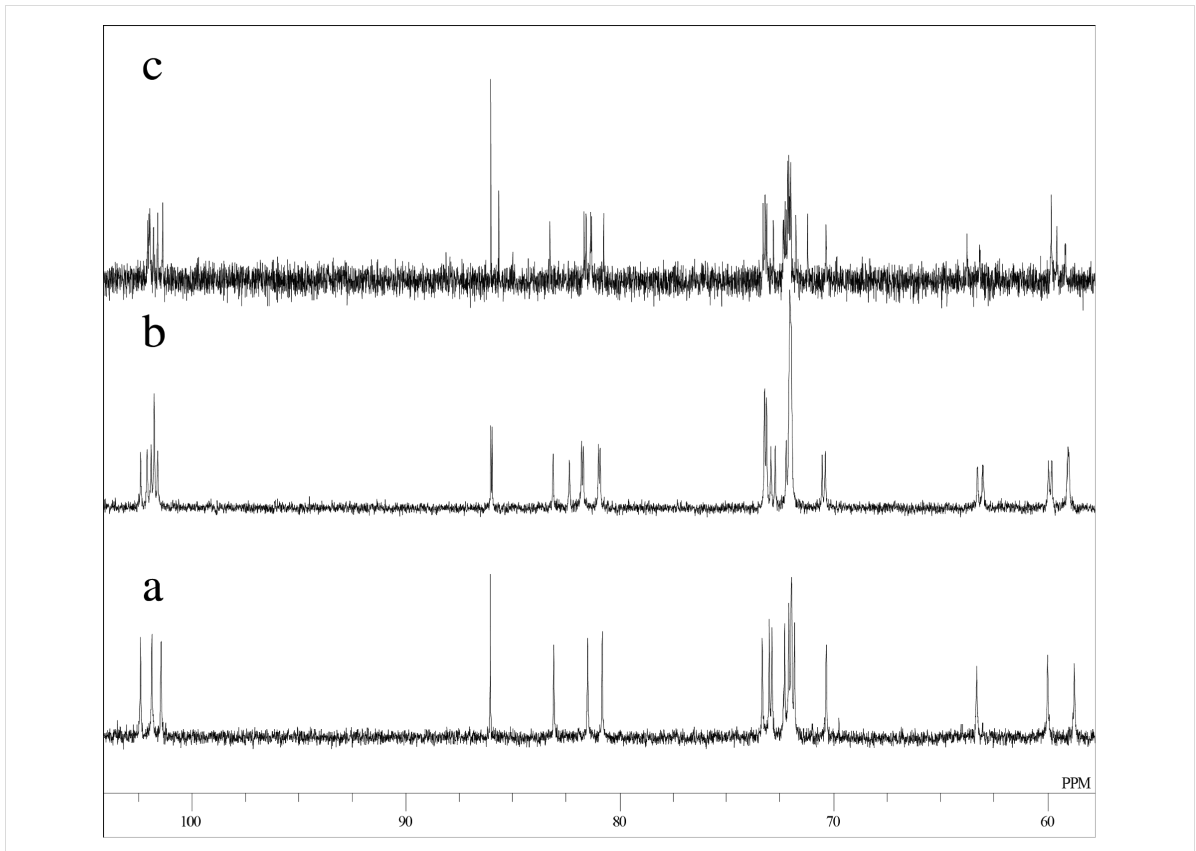
Figure 3: A part of 13 C NMR spectra of di-6- O -trityl- α -CD in DMSO- d 6 at 50 °C a) AD-isomer, b) AC-isomer, and c) AB-isomer.